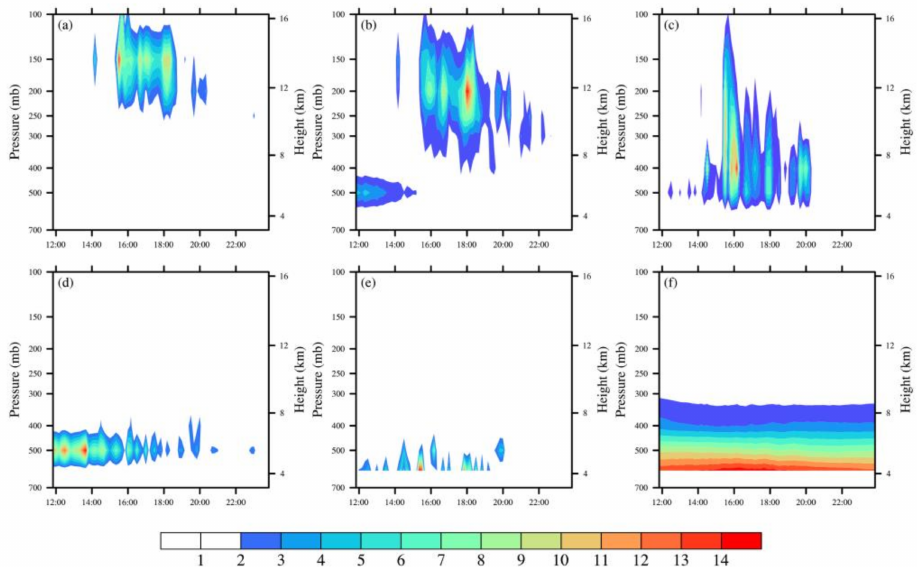
Figure 6. The mixing ratios of particles in each phase: ( a ) ice, ( b ) snow, ( c ) graupel, ( d ) cloud water, ( e ) rainwater, ( f ) water vapor (unit: 10 − 6 kg/kg). This figure is obtained via regional averaging of the black dashed area (32.5–33.5 ◦ E, 96.5–97.5 ◦ N) in Figure